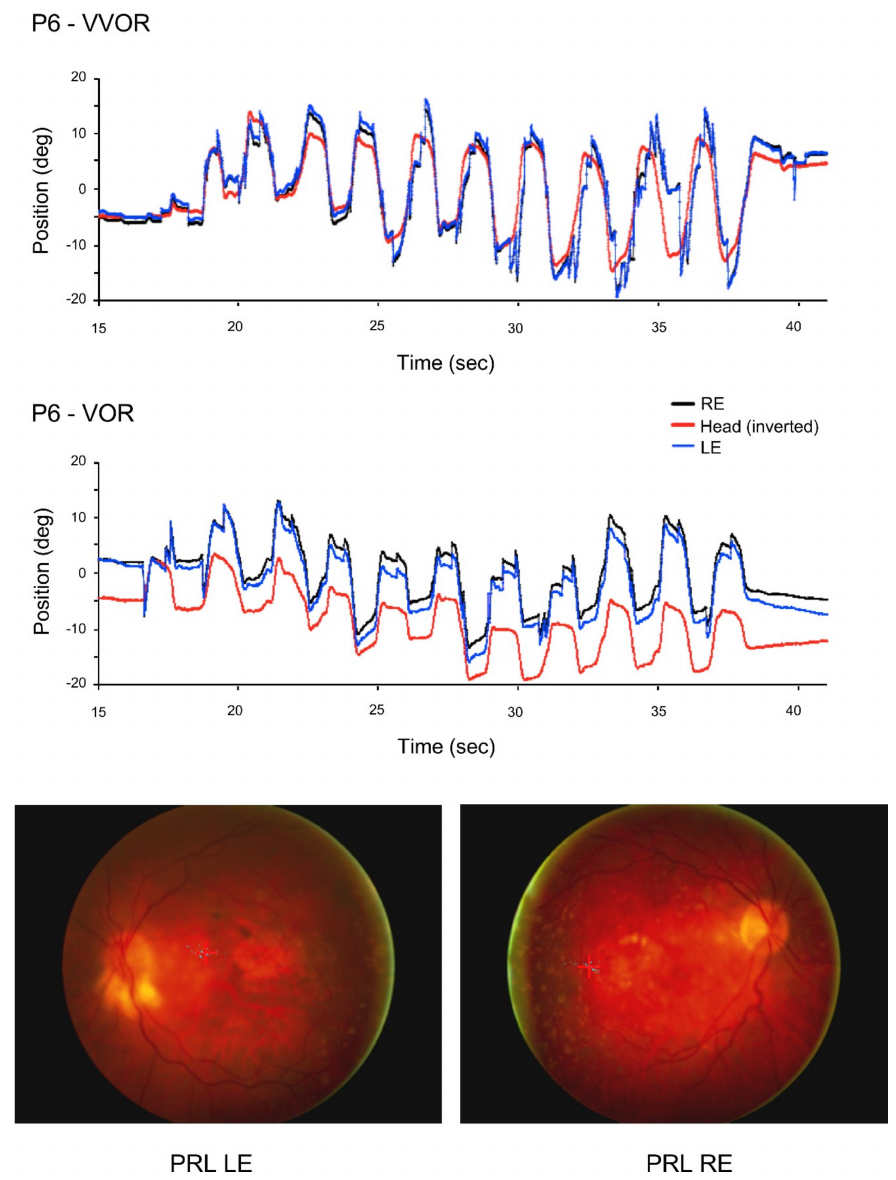
Figure 2. For patient P6, right (RE), left (LE) eye and head position traces in the light (VVOR, above) and in the dark (VOR, below) for the complete testing period. The values of the head’s position coordinates are inverted so that the eye and head curves can be overlapped. Fundus photographs show that the preferred retinal locus (PRL) is located on the left of the scotoma in the visual field for both